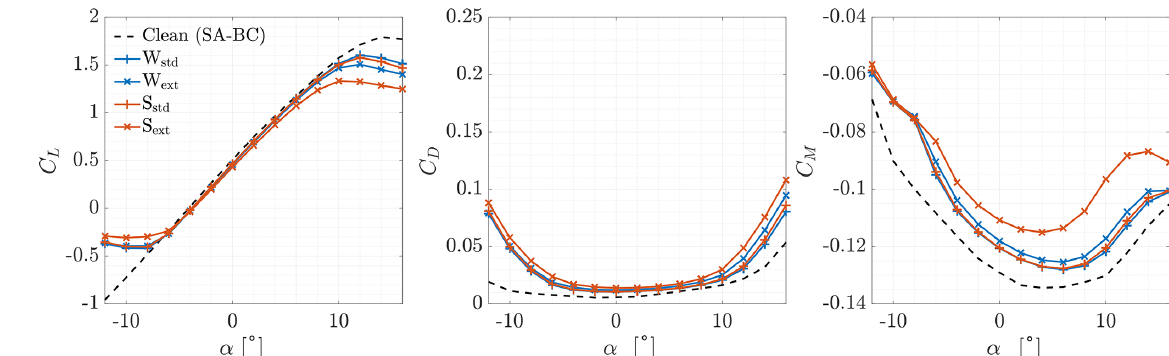
Figure 20. Aerodynamic coefficients of Section D.